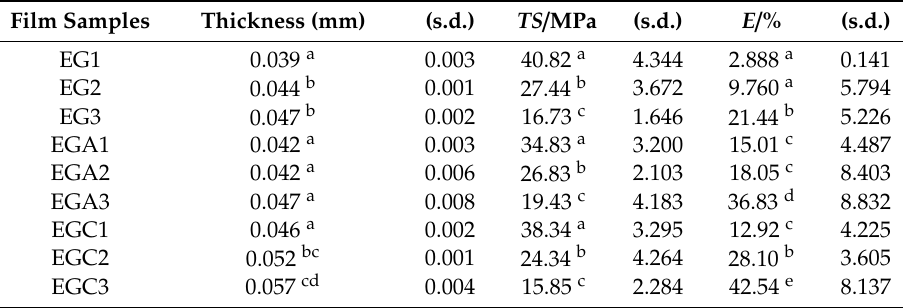
Table 3. Film thickness and mechanical properties of